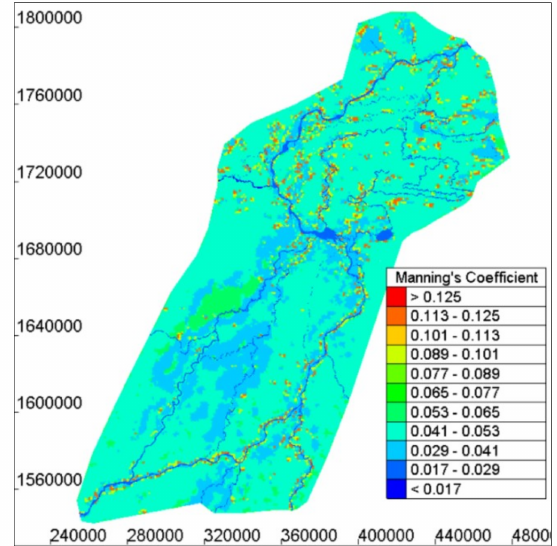
Figure 7. Manning’s coe ffi cient at the floodplain of Inner Niger Delta